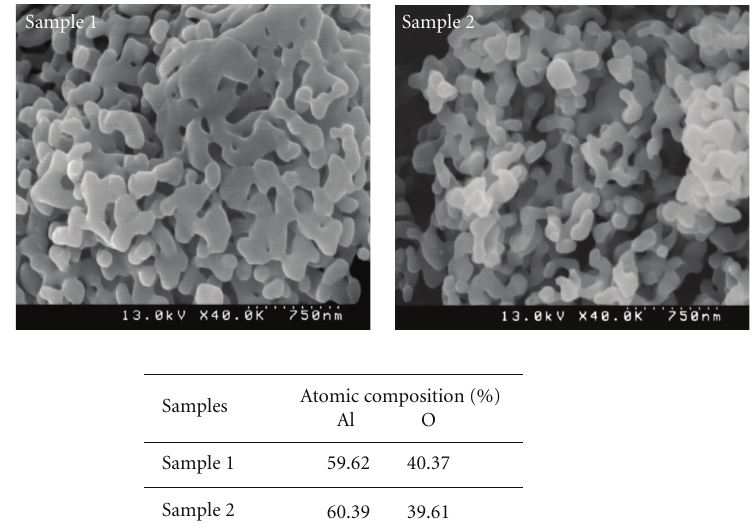
Figure 3: The SEM images and the atomic compositions analyzed by energy-dispersive X-ray spectroscopy (EDS)